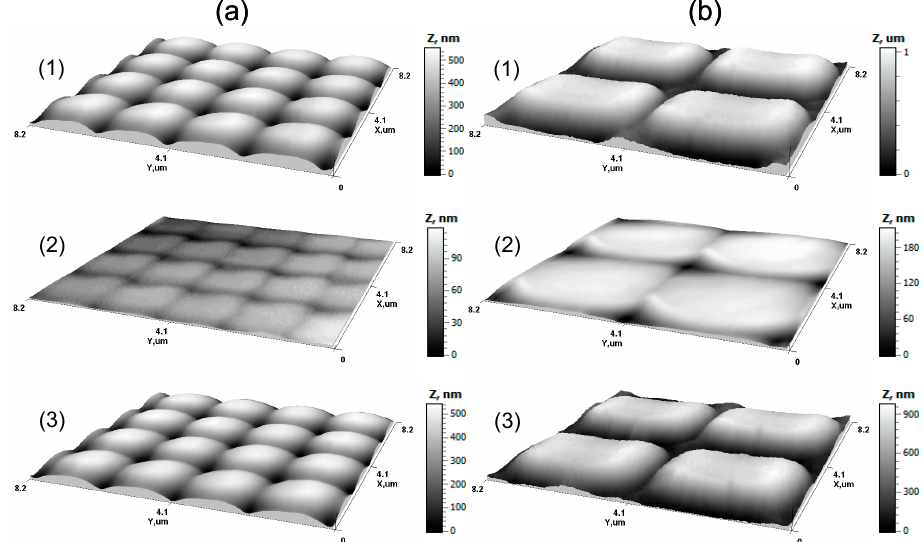
Figure 4. Atomic force microscopy (AFM) 3D topographical images with normalized Z axis in nm: ( a1 ) 2A and ( b1 ) 4B imprinted micropillars on the PETMP-TTT film surface; ( a2 , b2 ) corresponding micropillars after deformation; ( a3 , b3 ) micropillars after recovery.